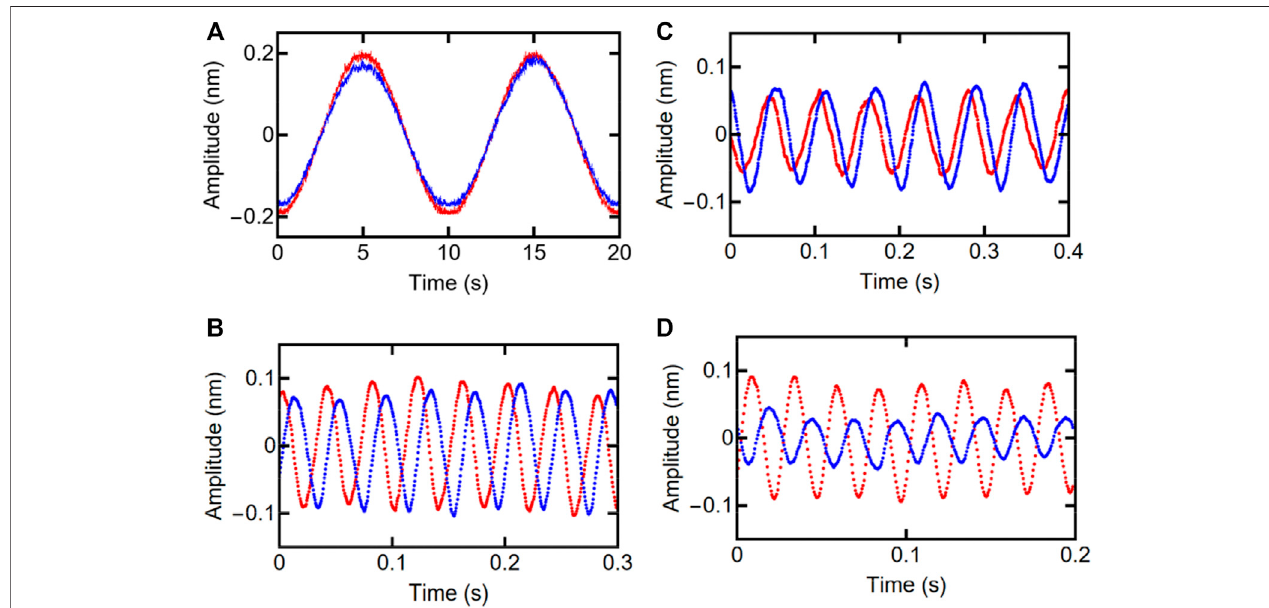
FIGURE 4 | The measured signals of two mechanical resonators as a function of time at different modulation frequencies (A) ω m = 2 π ×0.1 Hz, (B) ω m = 2 π ×17 Hz, (C) ω m = 2 π ×25 Hz, and (D) ω m = 2 π ×40 Hz. The red and blue curves represent the signals measured on membranes 1 and 2, respectively. The parameters for the experimental measurements are Λ = ‒ 2 π ×15 Hz, γ 1 = 2 π ×6 Hz, and γ 2 = 2 π ×12 Hz, and M = 0.6.